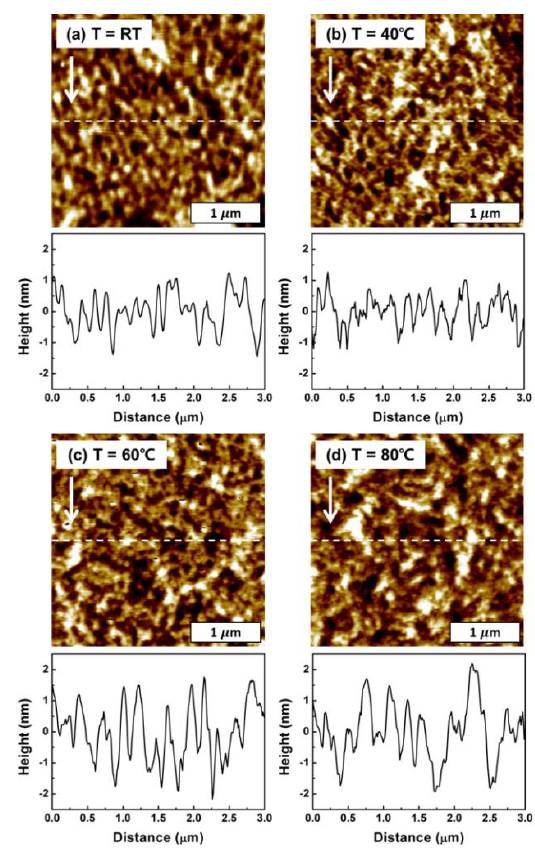
Figure 3. The atomic force microscopy (AFM) images (3 × 3 µ m) and corresponding height profile of the 29-DPP-SVS film blade-coated with substrate temperature at ( a ) RT, ( b ) 40 ◦ C, ( c ) 60 ◦ C, and ( d ) 80 ◦ C. The red arrows in the AFM image indicate the blade-coating direction.